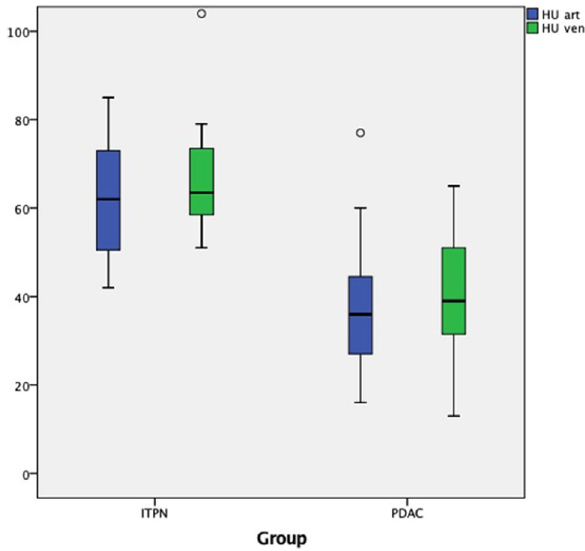
Figure 1. Box plots demonstrating attenuation differences in the group with ITPN and PDAC in the arterial and venous